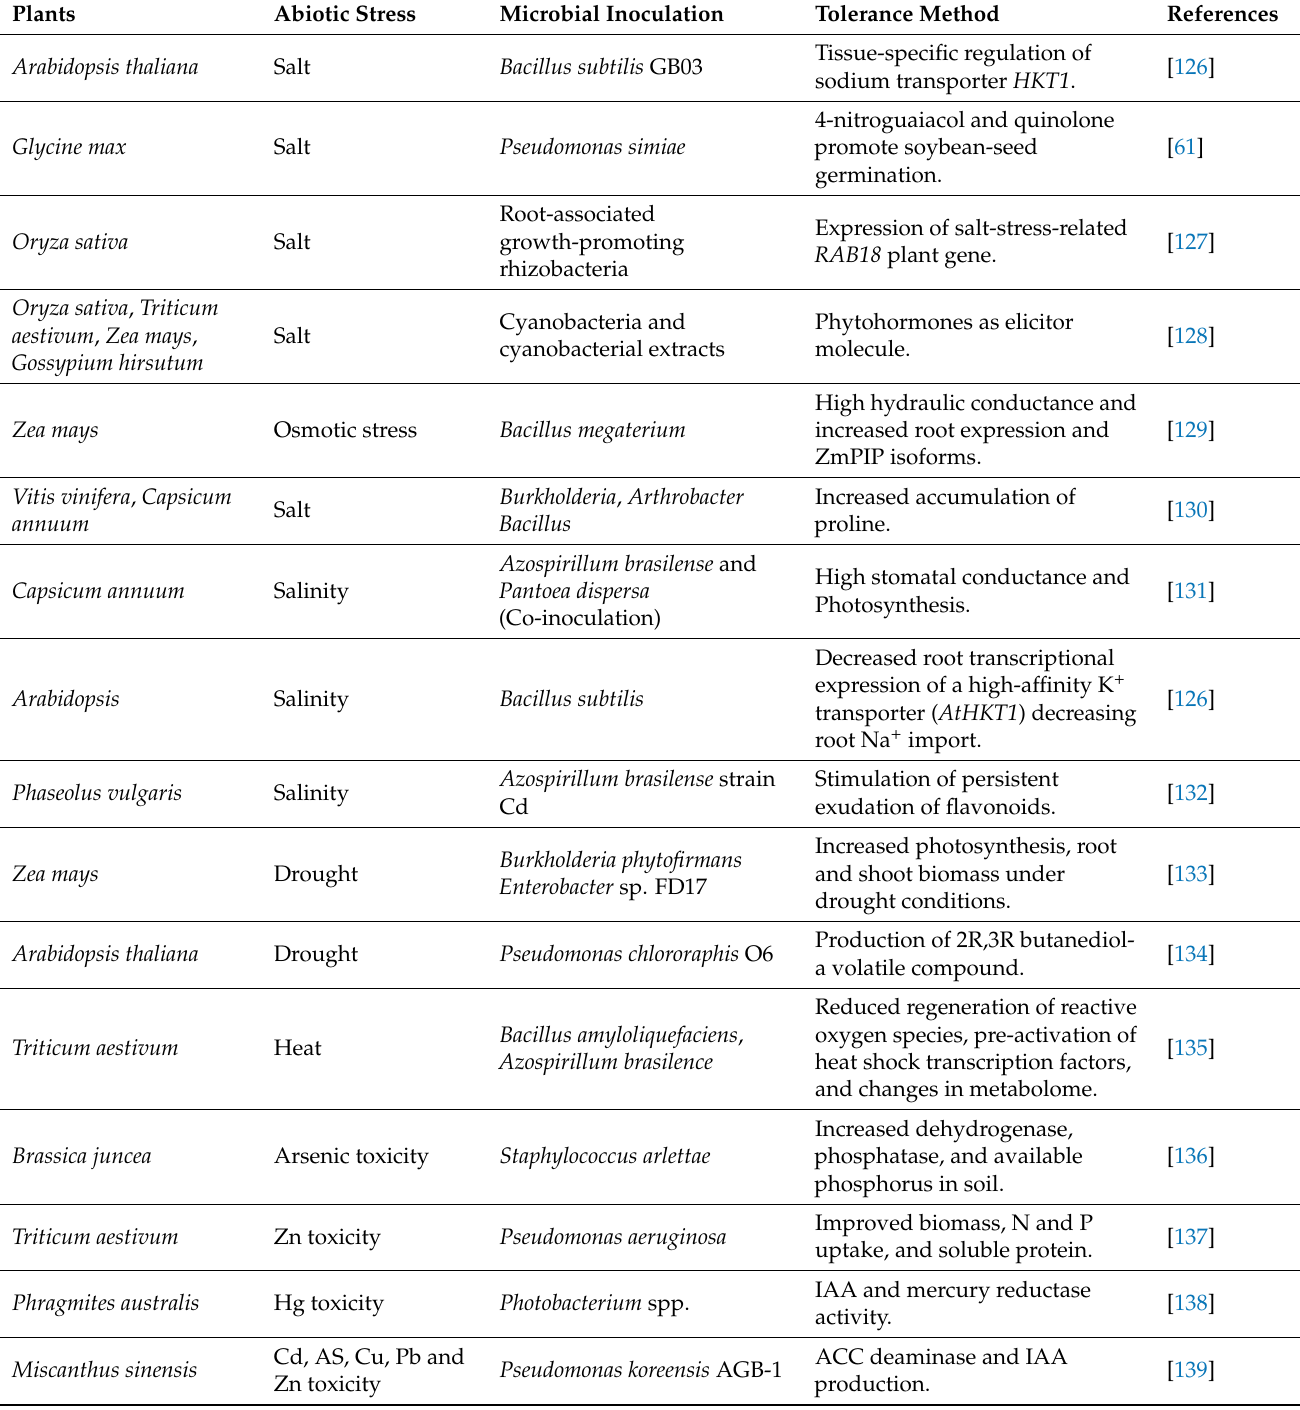
Table 1. Various tolerance strategies used to control abiotic stress in